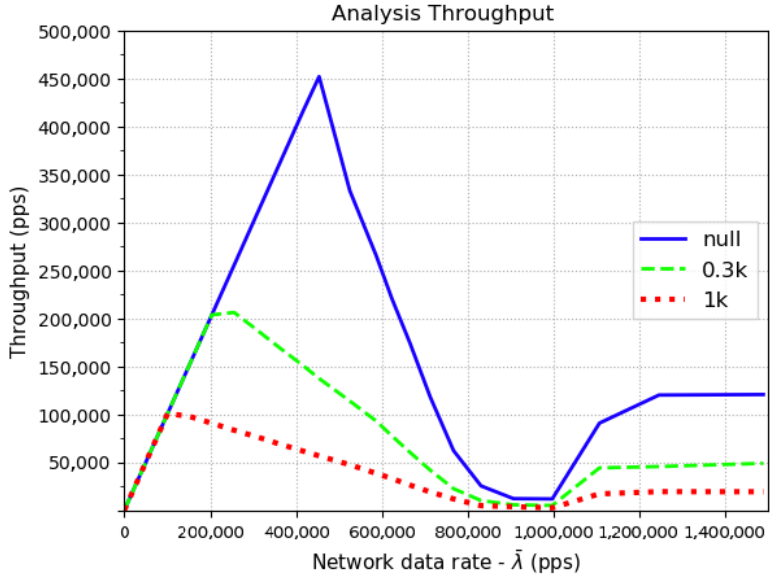
Figure 7. Performance achieved in the real traffic monitoring system.